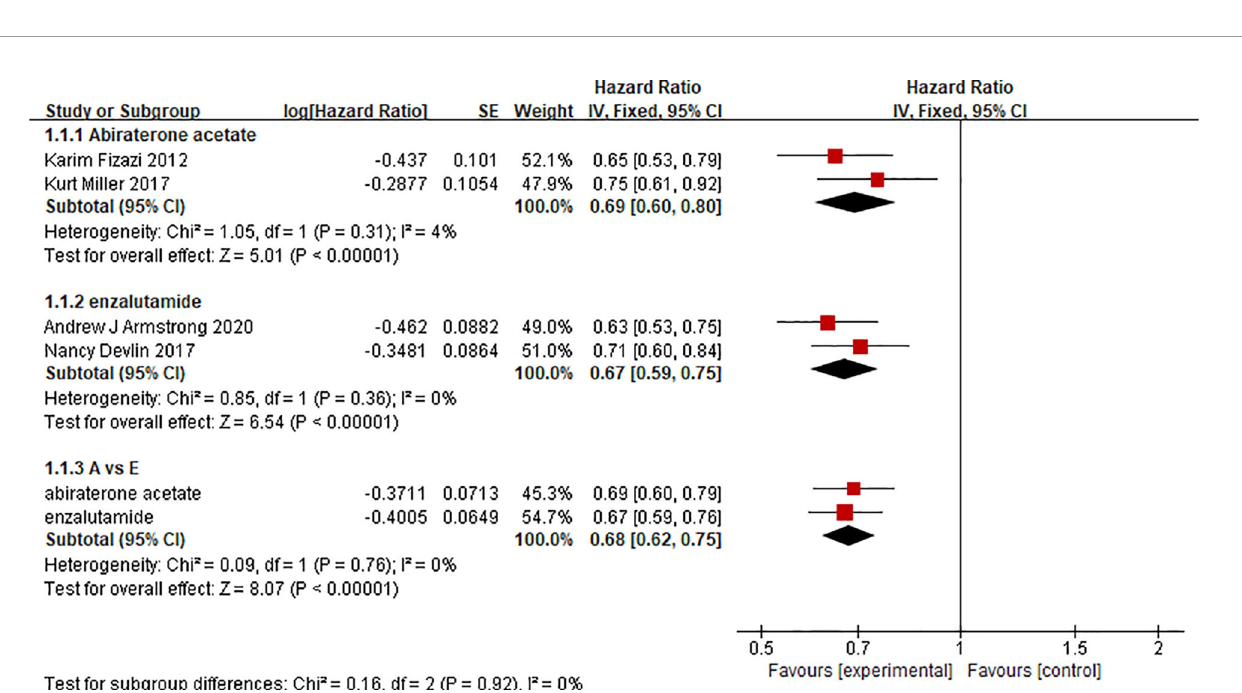
FIGURE 4 | Forest plots for Overall survival in studies.